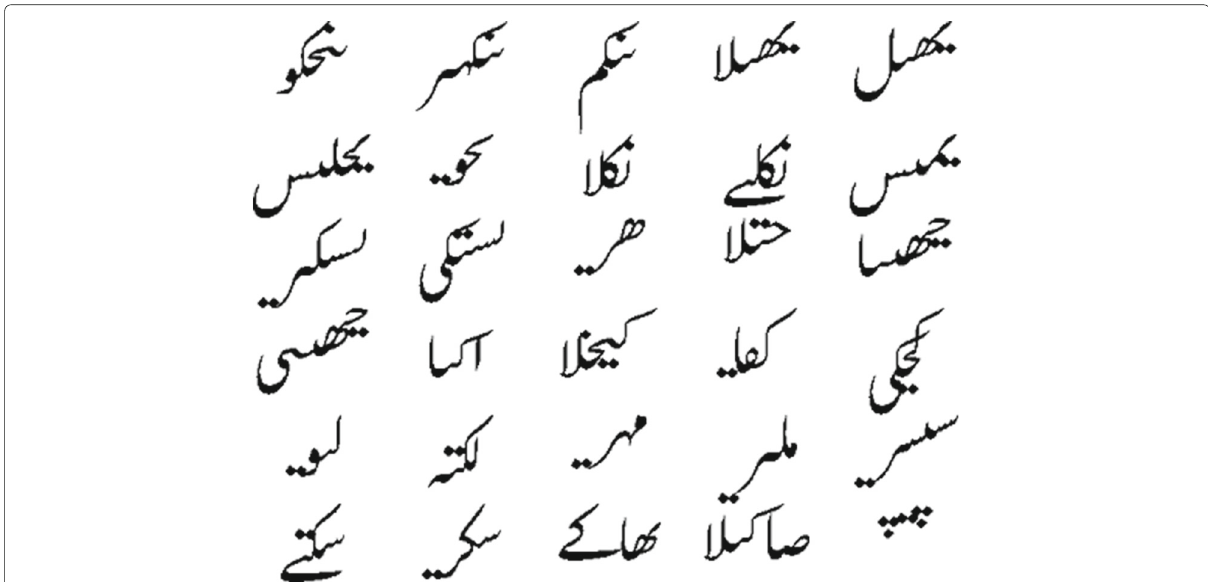
Fig. 19 Examples of joined ligatures resulting in a